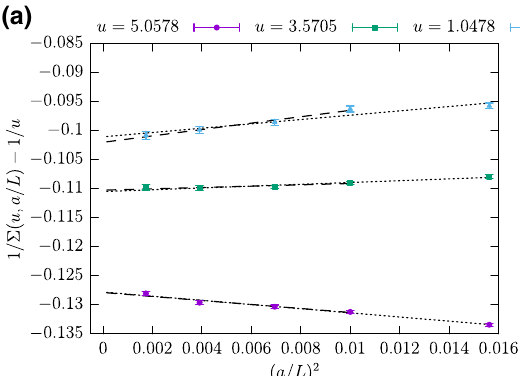
coarsest lattice, L / a = 8. b Slopes ˜ ρ of the continuum extrapolations of 1 /(cid:15) 2 (cf. Eq. (A.2)). (Data from Table 6.) As we can see, the slope is positive at weak couplings, while turns negative at strong